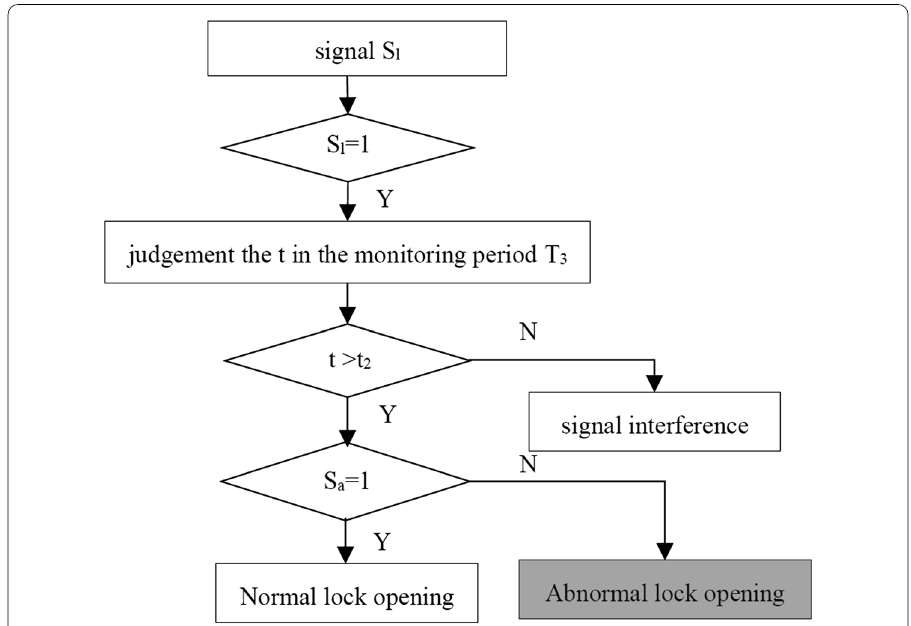
Fig. 6 The judgment method of the lock abnormally opening